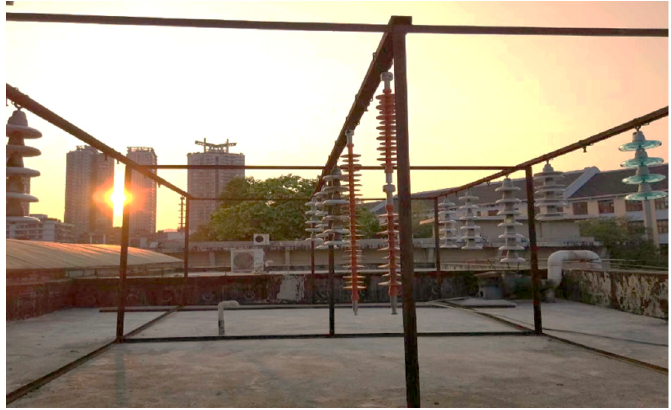
Figure 5. Field pollution tests.